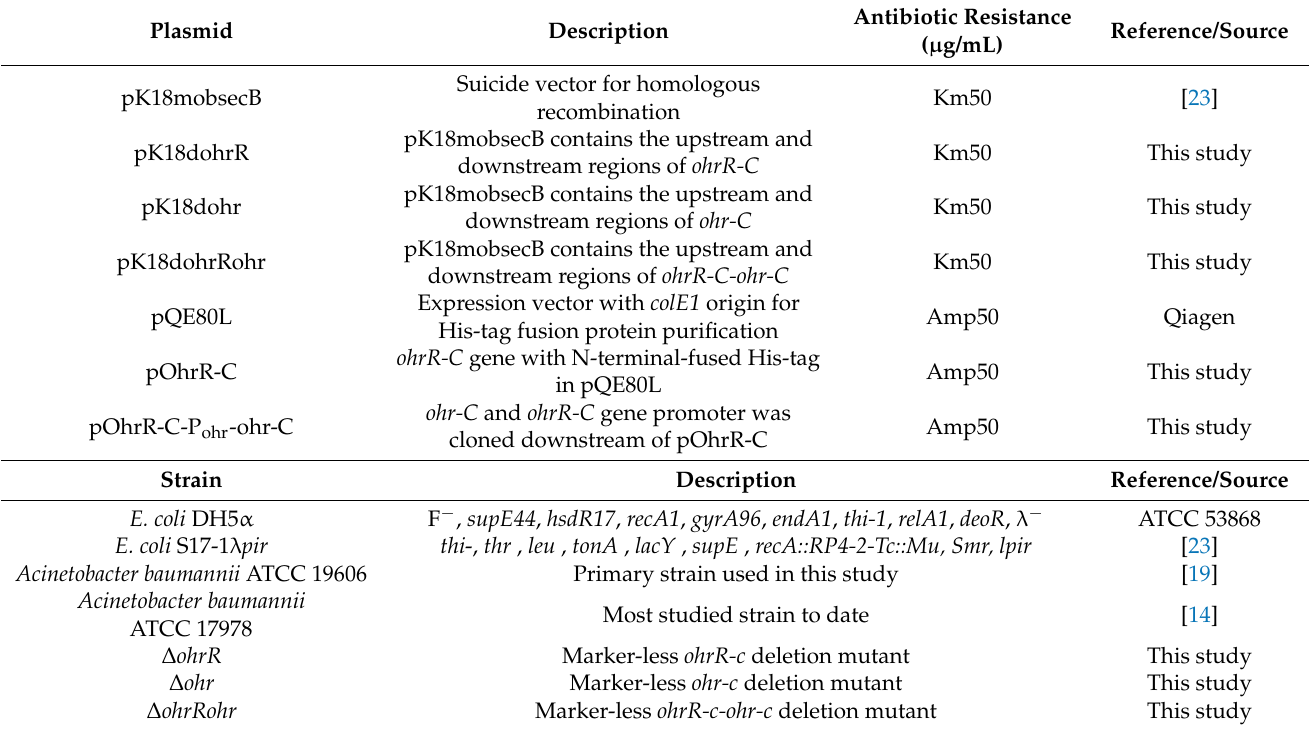
Table 1. Plasmids and bacterial strains used in this